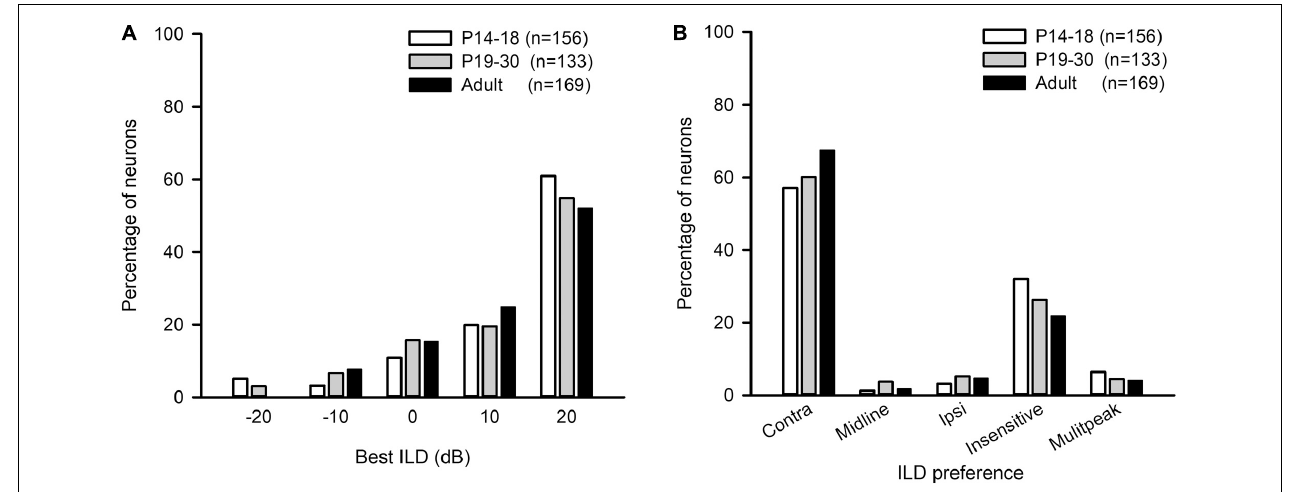
FIGURE 8 | The distributions of the best ILDs and the ILD preferences of AI neurons in the three age groups of rats. (A) The distributions of the best ILD. (B) The distributions of the ILD preference. “ n ” indicates the number of neurons in each group.